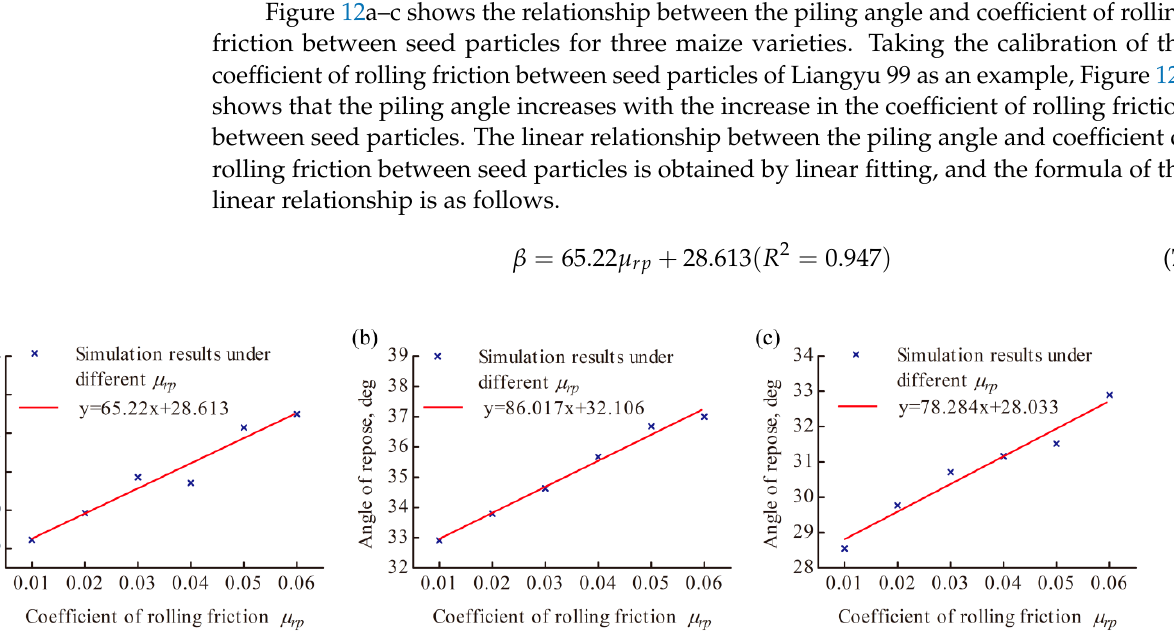
Figure 12. Calibration of the coefficient of rolling friction between seed particles for three maize varieties for three varie- ties: ( a ) Liangyu99, ( b ) Xianyu 335 and ( c ) Zhengda 999.